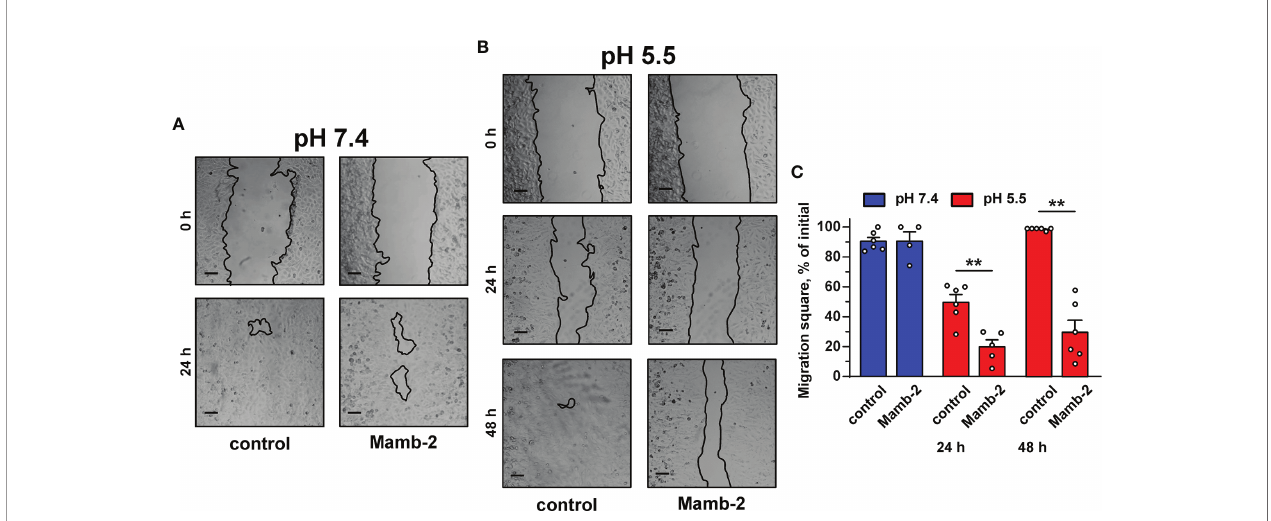
FIGURE 2 | In fl uence of mambalgin-2 on migration of A549 cells cultivated at pH 7.4 and 5.5. (A, B) Representative pictures of wounds for A549 cells incubated at pH 7.4 (A) and at pH 5.5 (B) in the absence or presence of 1 µM of mambalgin-2. Cells were incubated with mambalgin-2 at pH 7.4 for 24 h and at pH 5.5 for 48 h. Scale bar = 100 µm. (C) Wound area occupied by migrating A549 cells. Data are presented as % of the wound surface, occupied by migrating cells ± SEM (n = 6), **(p < 0.01) indicates signi fi cant difference between the data groups by two-tailed t-test.